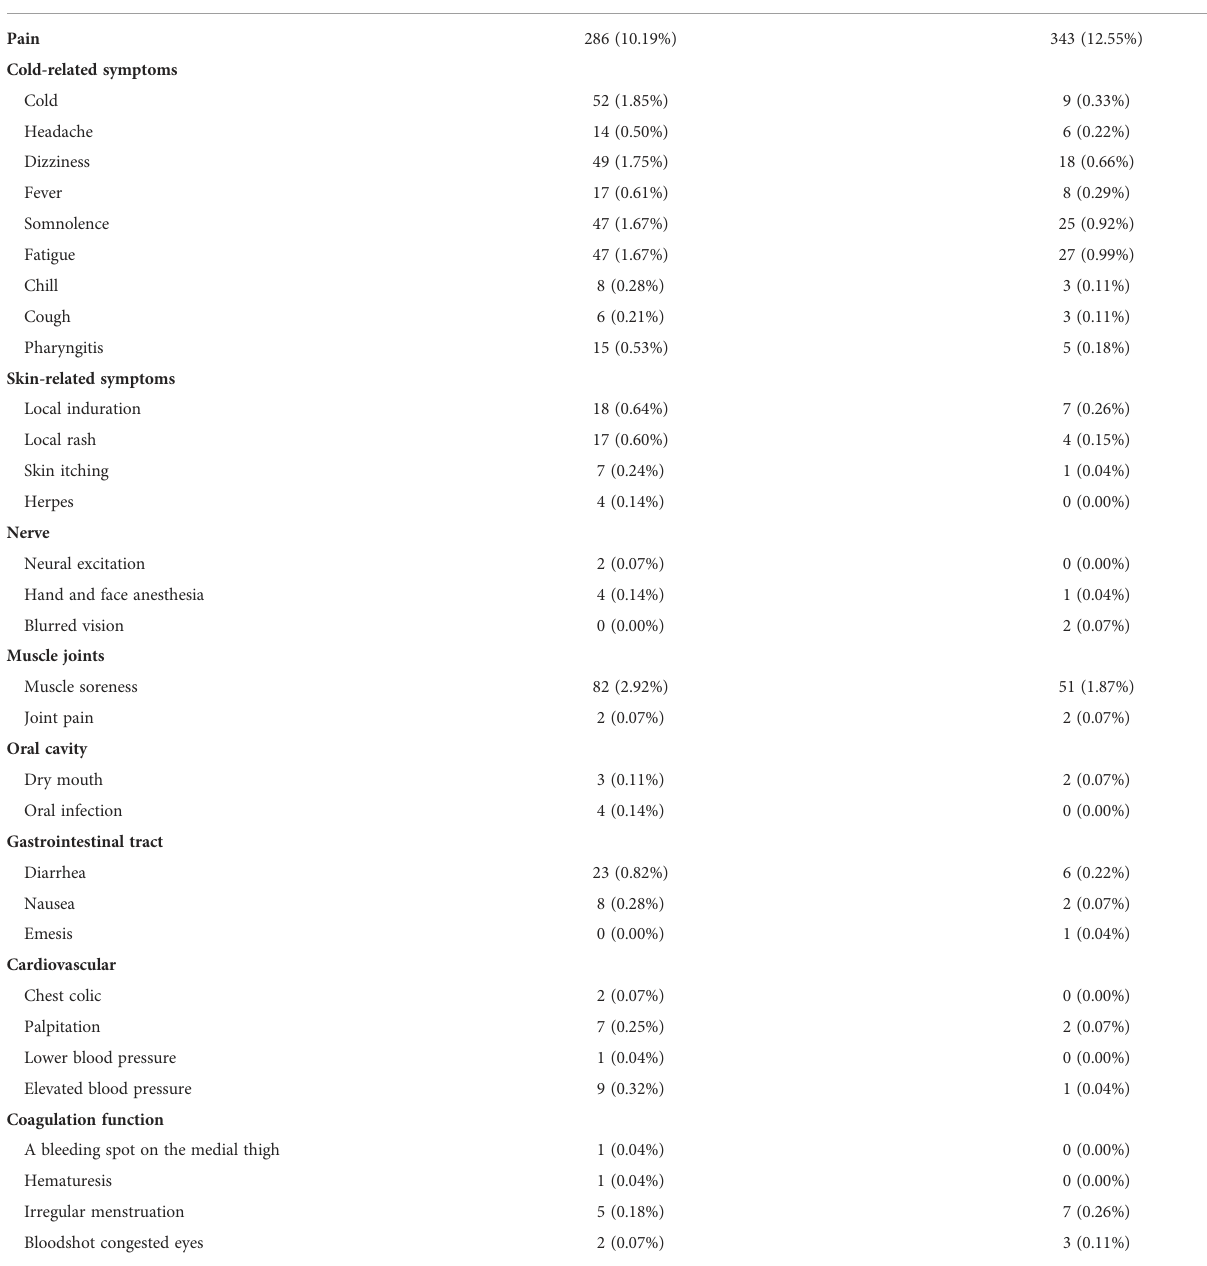
TABLE 2 Common manifestations of adverse events after